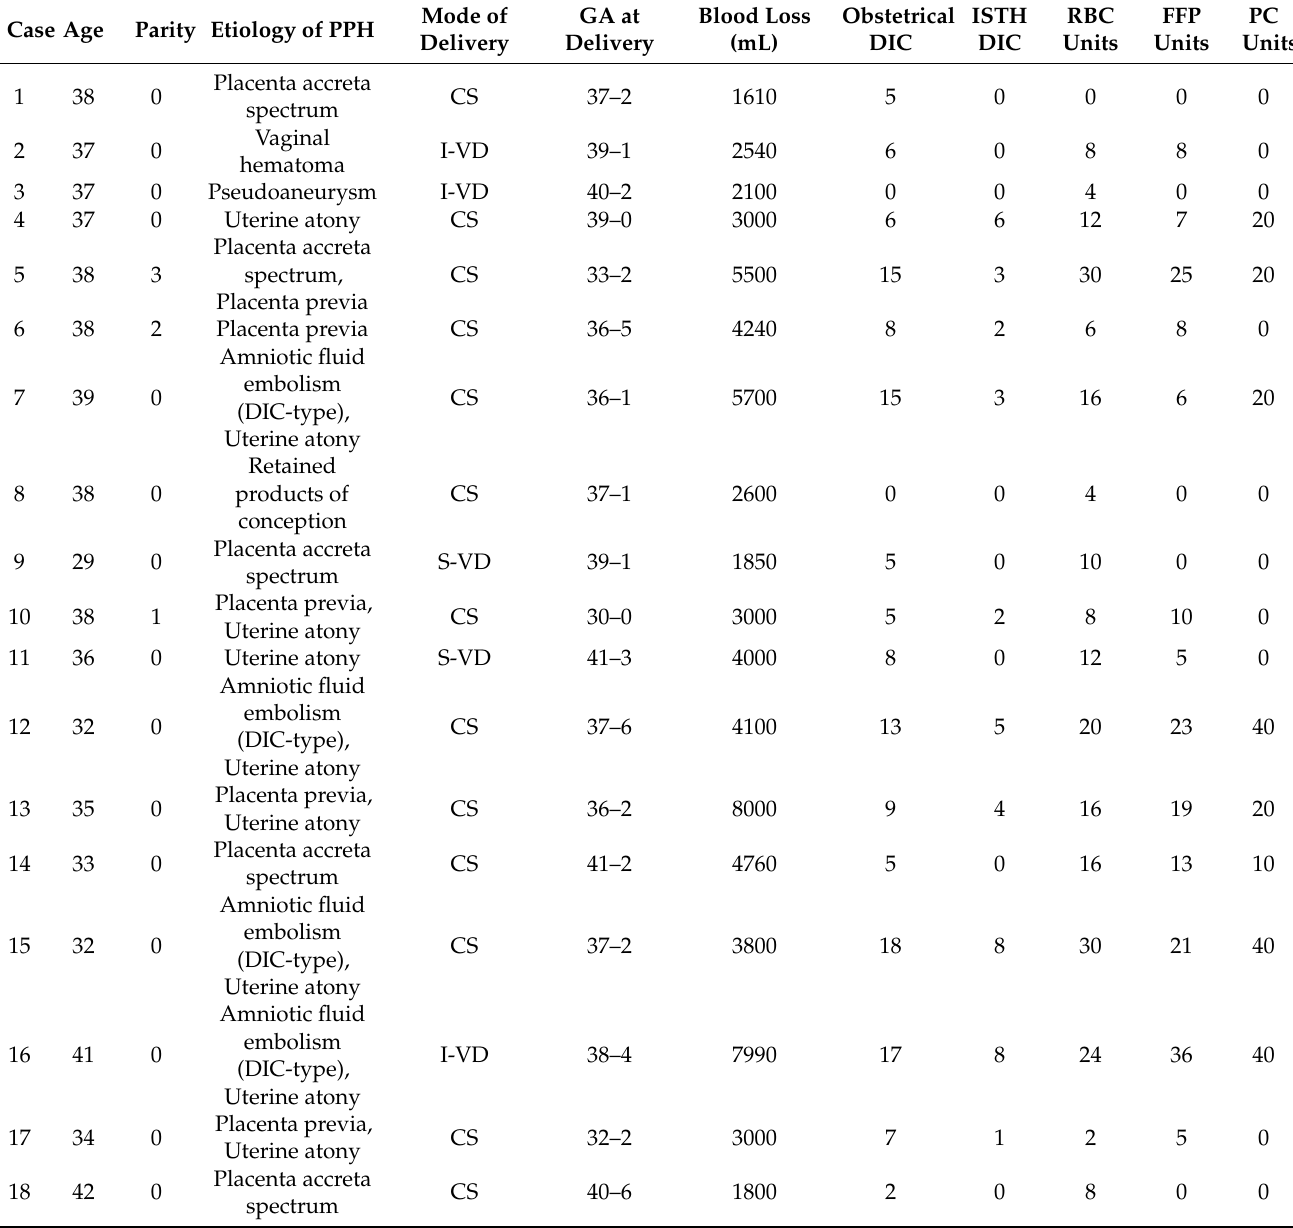
Table 1. Patient